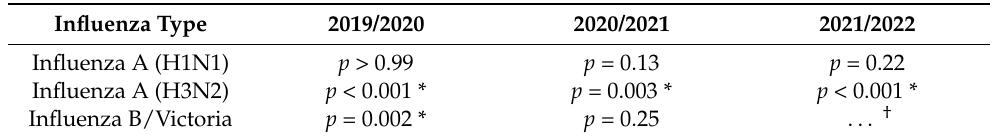
Table 5. Results of McNemar test assessing the consistency of changes in antibody positivity com- pared with those in the 2017/2018 season.